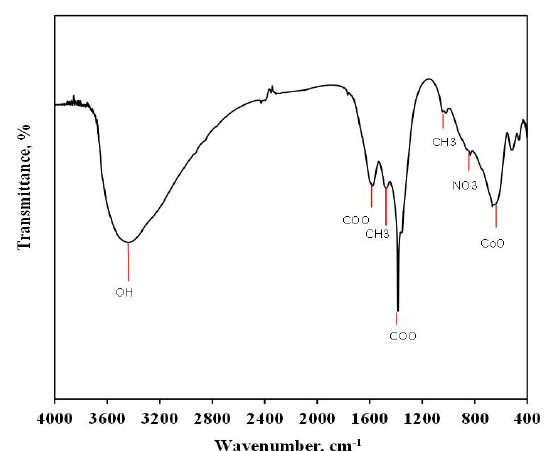
Figure 2. FTIR spectrum of as-deposited cobalt hydroxide.